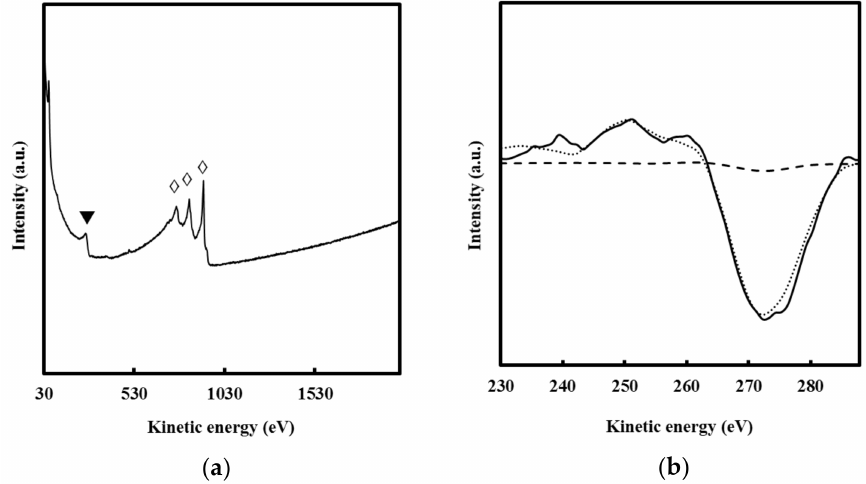
Figure 5. ( a ) Auger spectrum of F” mix . Peaks are denoted as follows: ♦ Cu and (cid:72) C. ( b ) Curve-fitting results for the carbon state in F” mix . The solid, dotted and dashed lines represent F” mix , C (neutral) and C (tetravalent),